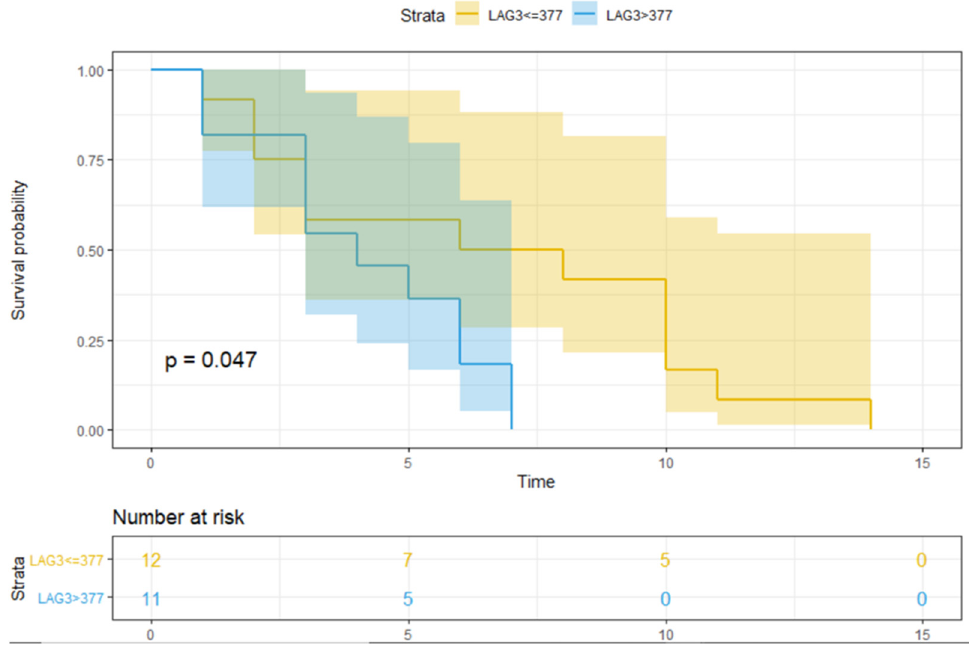
Figure 2. The PFS over time according to sLAG3 value. Figure 2 shows the PFS over time (expressed in months after the start of treatment) in patients with/without an LAG3 value higher than the median. The number of patients at risk is also indicated. PFS refers to progression-free survival; 377 is the median value of LAG3, expressed in pg/mL; the blue line represents OS in patients with sLAG3 > 377 pg/mL, and the yellow line represents OS in patients with sLAG3 ≤ 377 pg/mL; the shaded bands represent the confidence intervals at each time point. The table under the figure indicates the number of subjects in each group (i.e., sLAG3 > 377 or ≤ 377 pg/mL) at baseline (0) or at 5, 10, or 15 months after the beginning of treatment. p = p -value; significant p -values are indicated in bold. Table 3. p -values of univariate analysis of PFS and OS according to each